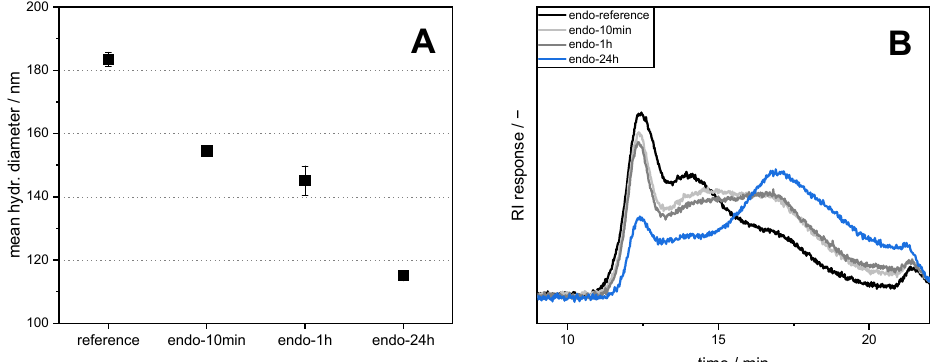
Figure 2. ( A ) Hydrodynamic diameter of the endo-reference sugar beet pectin and the enzymatically modified sugar beet pectins (endo-10min, endo-1h, and endo-24h, respectively) in solution at pH 3. ( B ) Elution patterns of the high performance size exclusion chromatography coupled with refractive index detection (HPSEC-RI) of the respective sugar beet